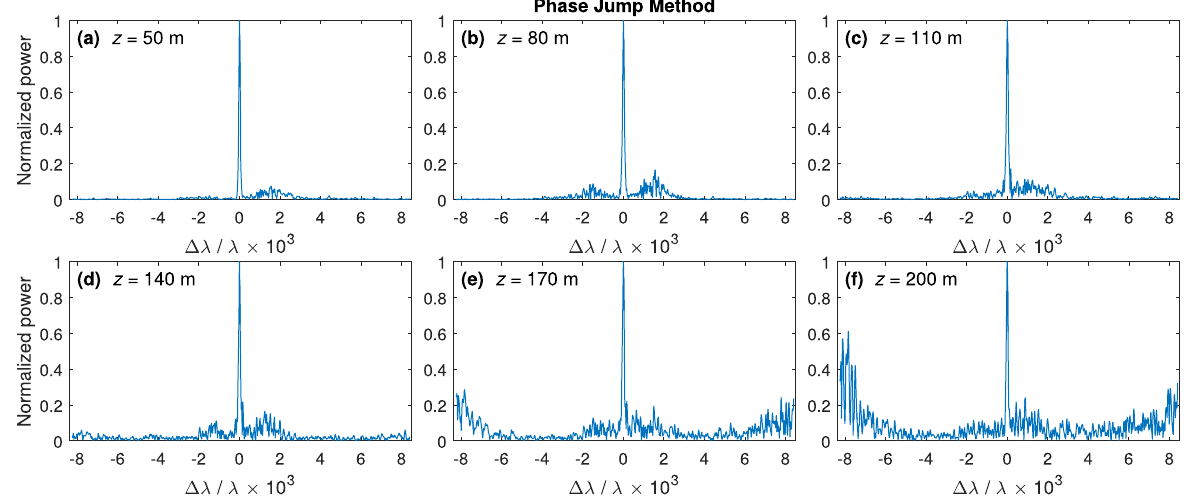
FIG. 12. Result of time-dependent simulation. The evolution of the optical spectrum for the optimal phase jumps is illustrated with the snapshots at six positions along the undulator